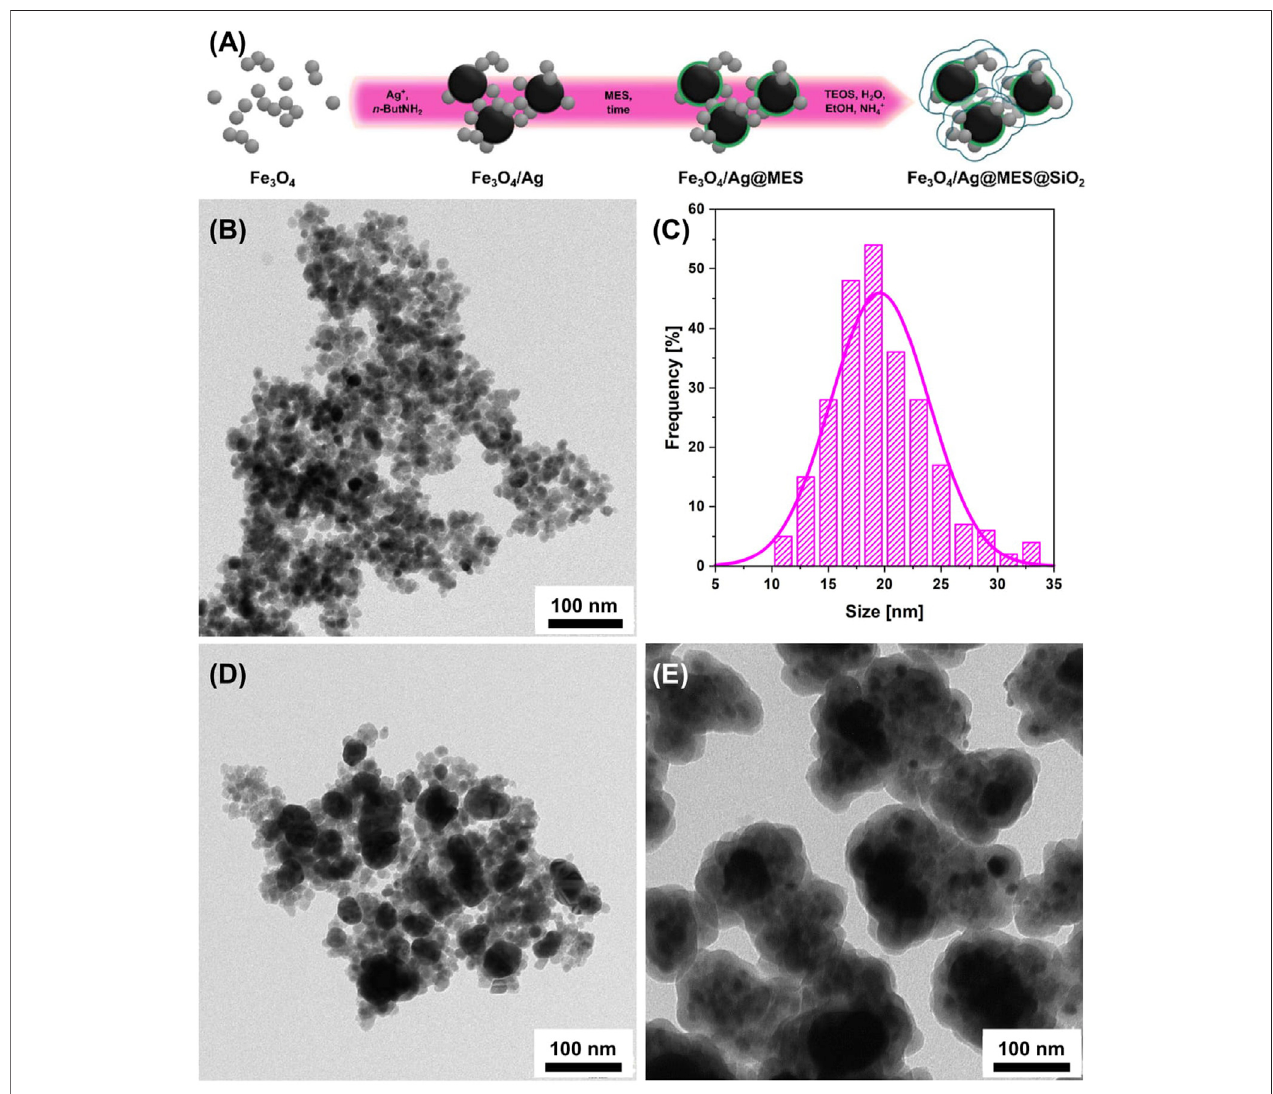
FIGURE 1 | (A) Schematic illustration of the preparation of Fe 3 O 4 /Ag@MES@SiO 2 nanocomposite. Representative TEM images of (B) Fe 3 O 4 (together with histogram showing the particle size distribution of this sample in part (C) ; (D) Fe 3 O 4 /Ag and (E) . Fe 3 O 4 /Ag@MES@SiO 2 nanomaterials.